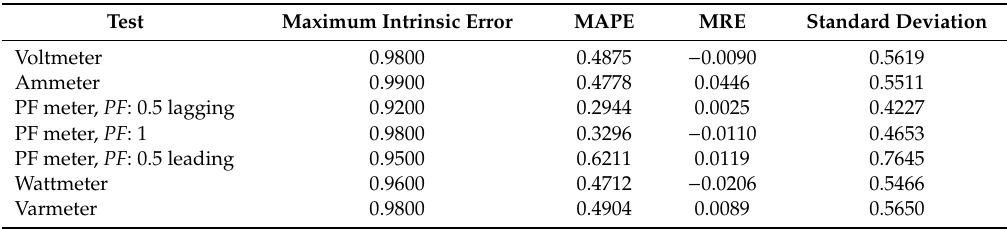
(%), and standard deviation (%).